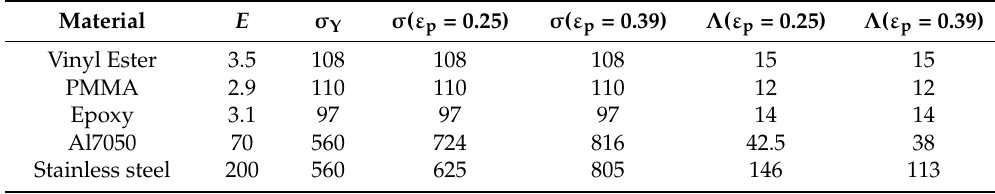
Table 1. Material properties as presented by Wredenberg and Larsson [20] and utilized in the present analysis. The value on Young’s modulus is given in GPa, while all stress quantities are given in MPa. The parameter Λ as defined in Equation (1) is